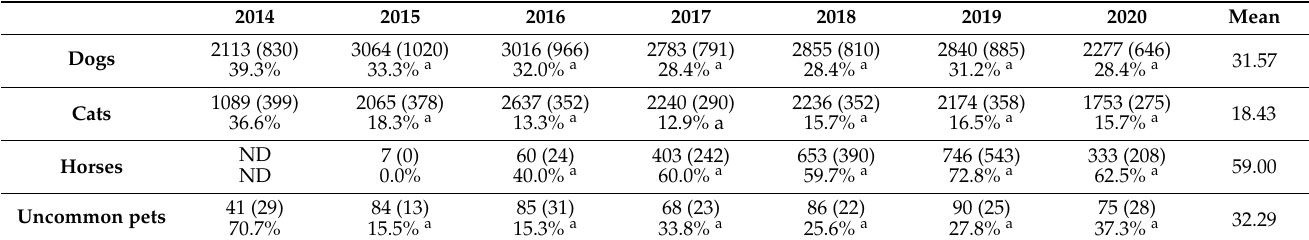
Table 2. Distribution of prescriptions by species regardless of drugs. Values in parentheses refer to the number of antimicrobial prescriptions. Percentages refer to the frequency of antimicrobial prescription in the corresponding species. a Statistically significant frequency variation with 2014 as the reference